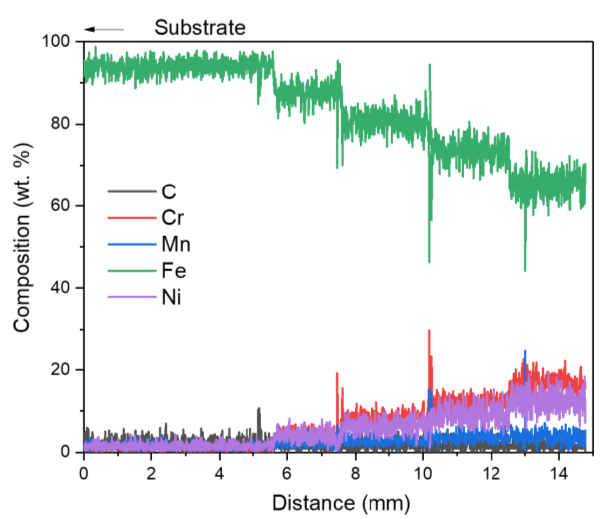
Figure 14. The result of energy dispersive spectrometer (EDS) line scanning for the mild steel/Fe(B) + STS316.